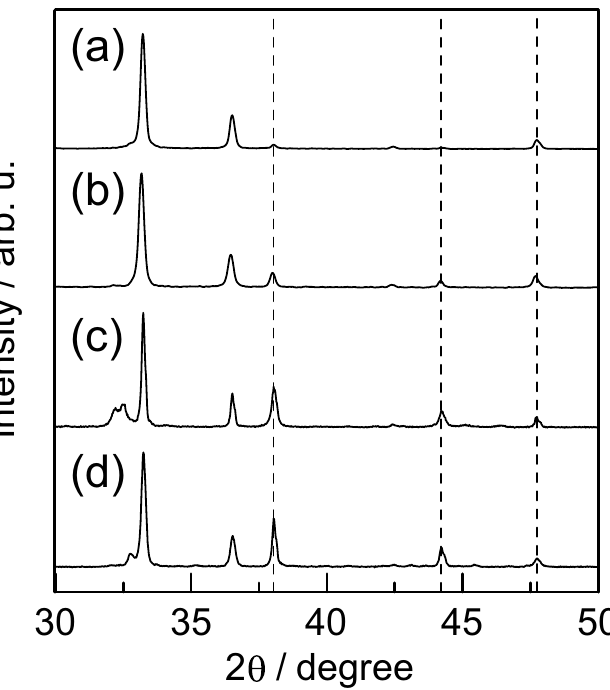
Figure 6. XRD patterns for raw silver phosphate calcined at ( a ) 300 °C, ( b ) 500 °C and silver phosphate paste calcined at ( c ) 300 °C, ( d ) 500 °C. Here, the composition ratio for silver phosphate paste is 1.0:1.0:0.030 (Ag 3 PO 4 :H 2 O:CMC-Na). The dashed vertical line represents the diffraction angle for elemental